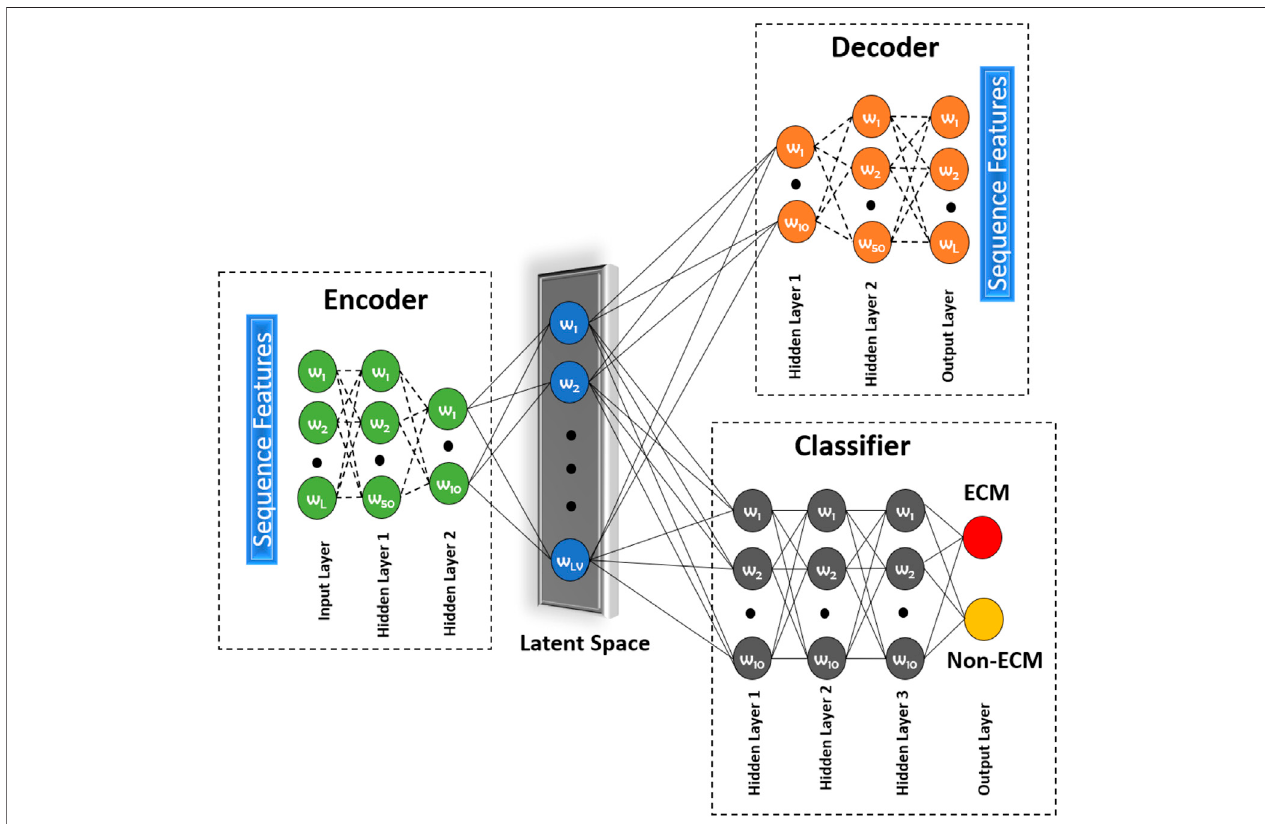
FIGURE2| ProposedDeepLSEarchitectureforECMclassi fi cation.Themodelcomprisesofanencoder,adecoder,andaclassi fi ermodule.Theencoderconsists ofaninputlayerand twohiddenlayersthatembed inputfeaturestolatent variables( LVs ).Thedecoderarchitectureismirrorsymmetryoftheencoderwhichuses LVs as itsinputandgeneratesthedecodedoutput.Theclassi fi cationmoduleuseslatentspacefeaturesasitsinputandfourlayersoffullyconnectedneurons.Eachhiddenlayer has 10 neurons, except for the last layer which produces a one-hot – encoded output of ECM/non-ECM class.